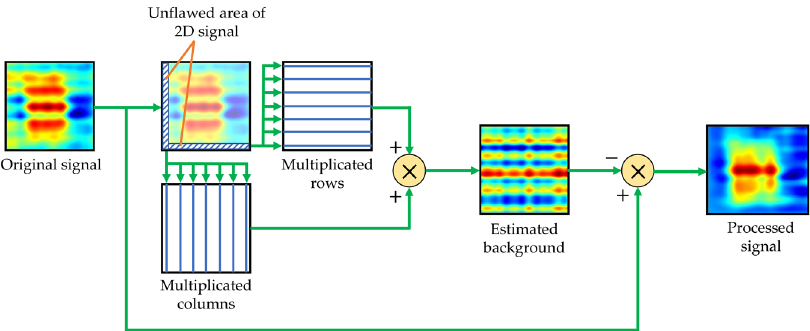
Figure 11. Signal processing algorithm for the background signal removal.